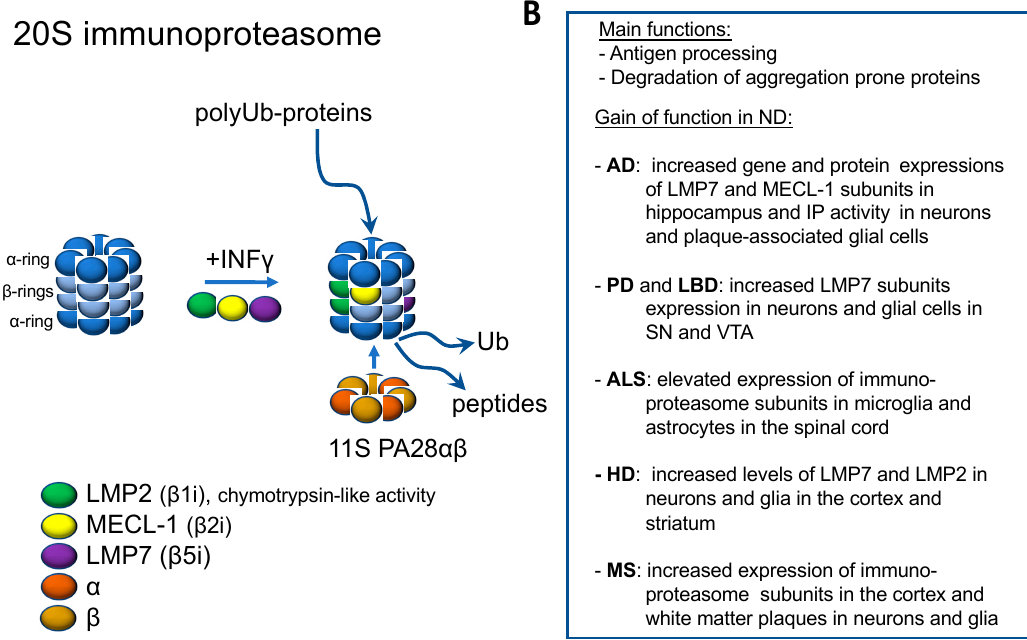
Figure 2. Immunoproteosome and its function in neurodegenerative diseases. ( A ) Immunoproteosome is formed from the constitutive proteosome upon inflammatory stimuli by the incorporation of specific β subunits and the co-production of proteosomal activator 11S PA28 αβ . ( B ) Evidence for the increased function of immunoproteosome in neurodegenerative diseases.